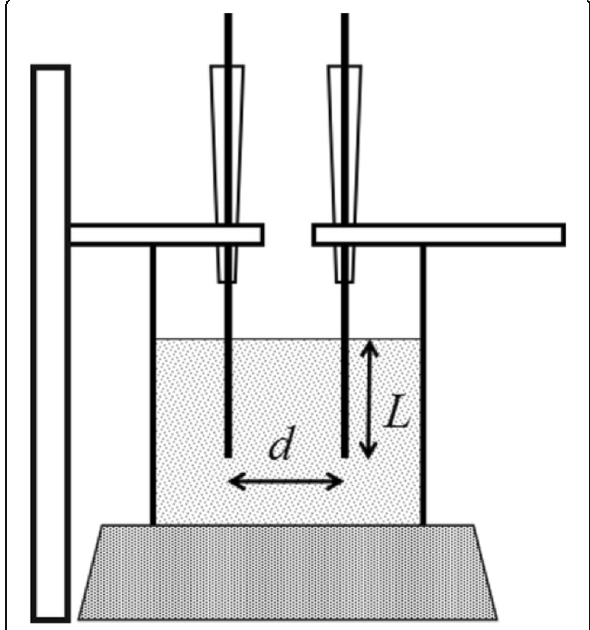
Fig. 12 Illustration of the parallel distance-variable electrode